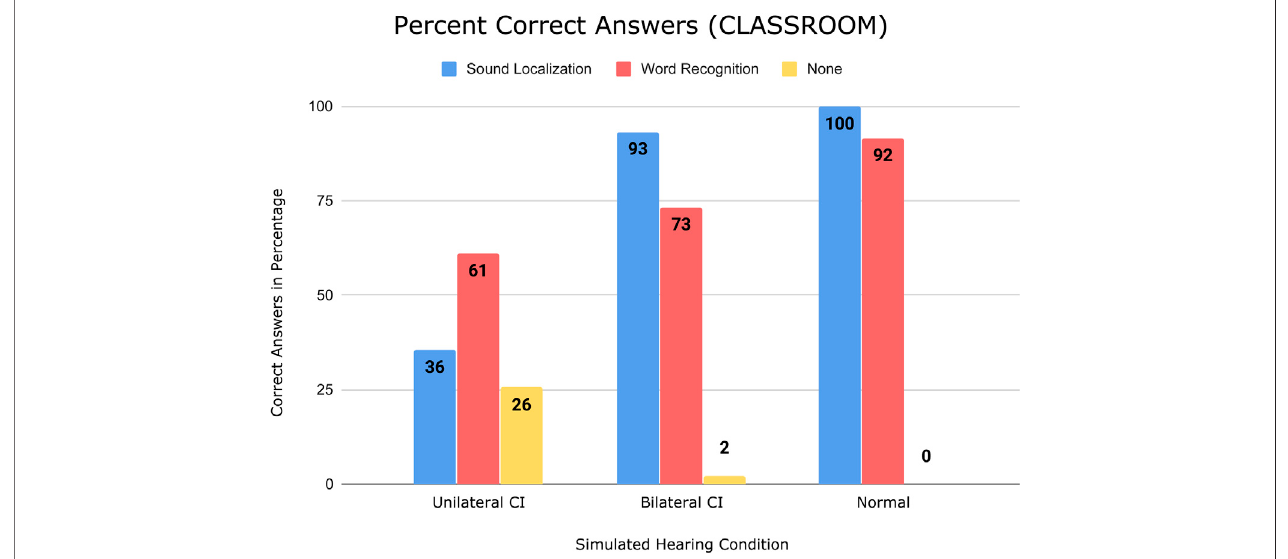
FIGURE 9 | Bar chart showing simulated hearing conditions on the horizontal axis and correct answers in percentage on the vertical axis, from testing in the classroom setting.